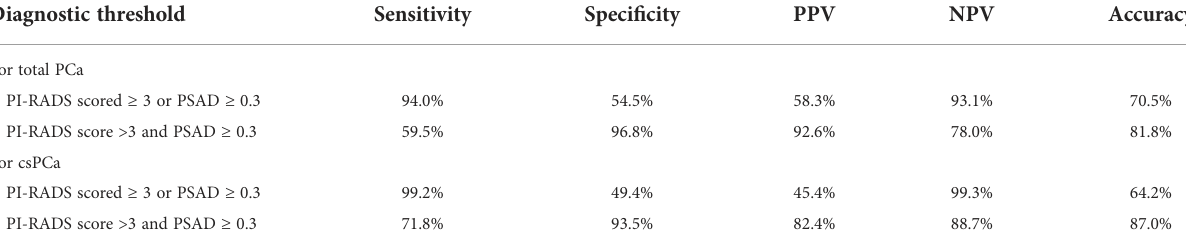
TABLE 3 Diagnostic accuracy of total PCa and csPCa by different diagnostic